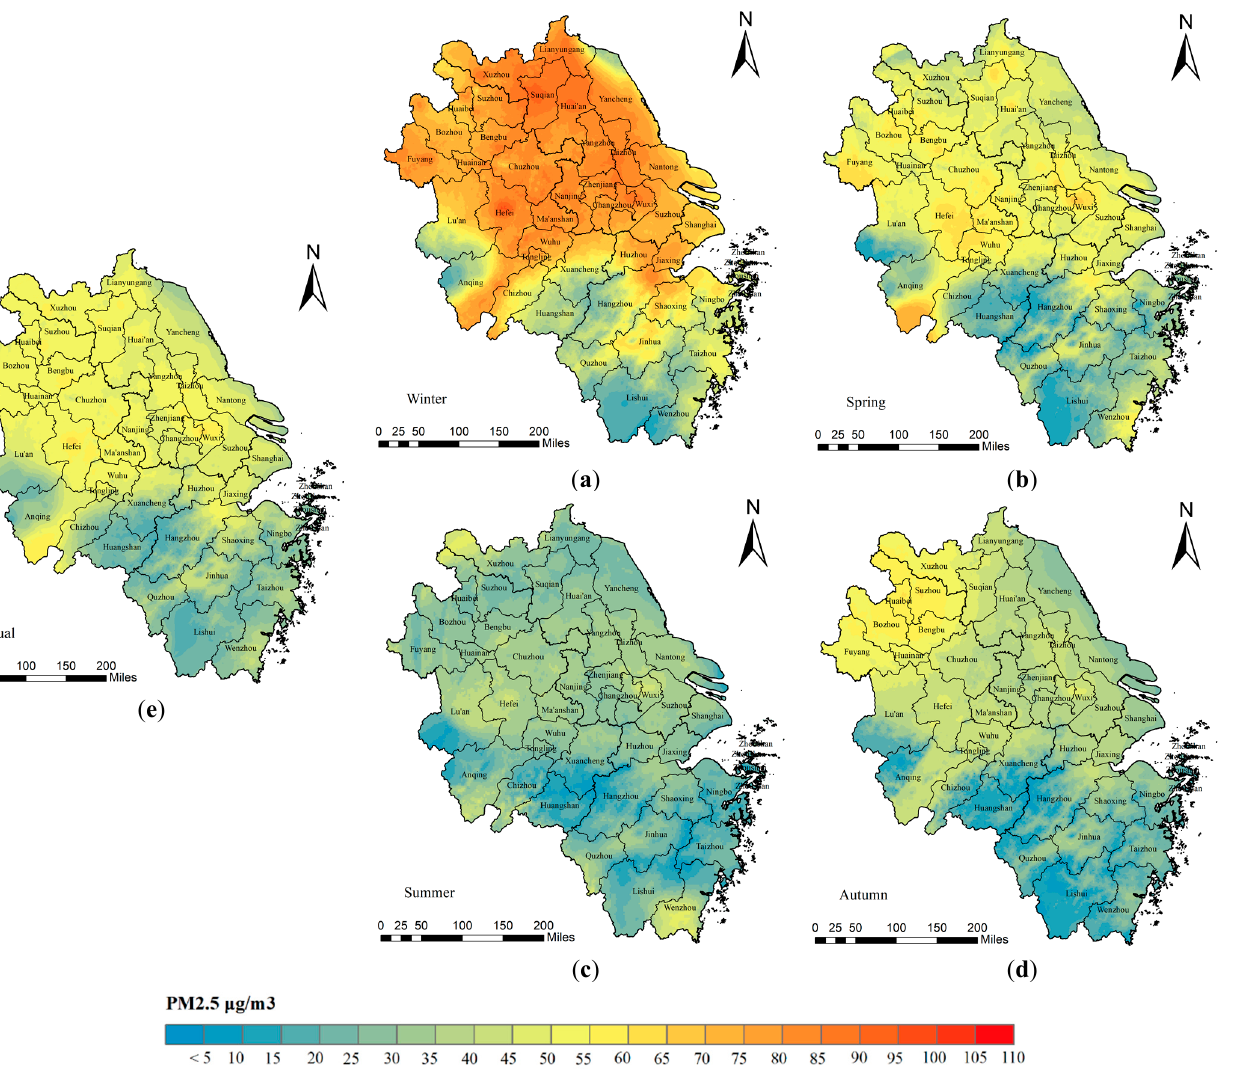
Figure 4. Estimated seasonal and annual PM 2.5 concentration distribution maps in the YRD region: ( a ) winter; ( b ) spring; ( c ) summer; ( d ) autumn; ( e )